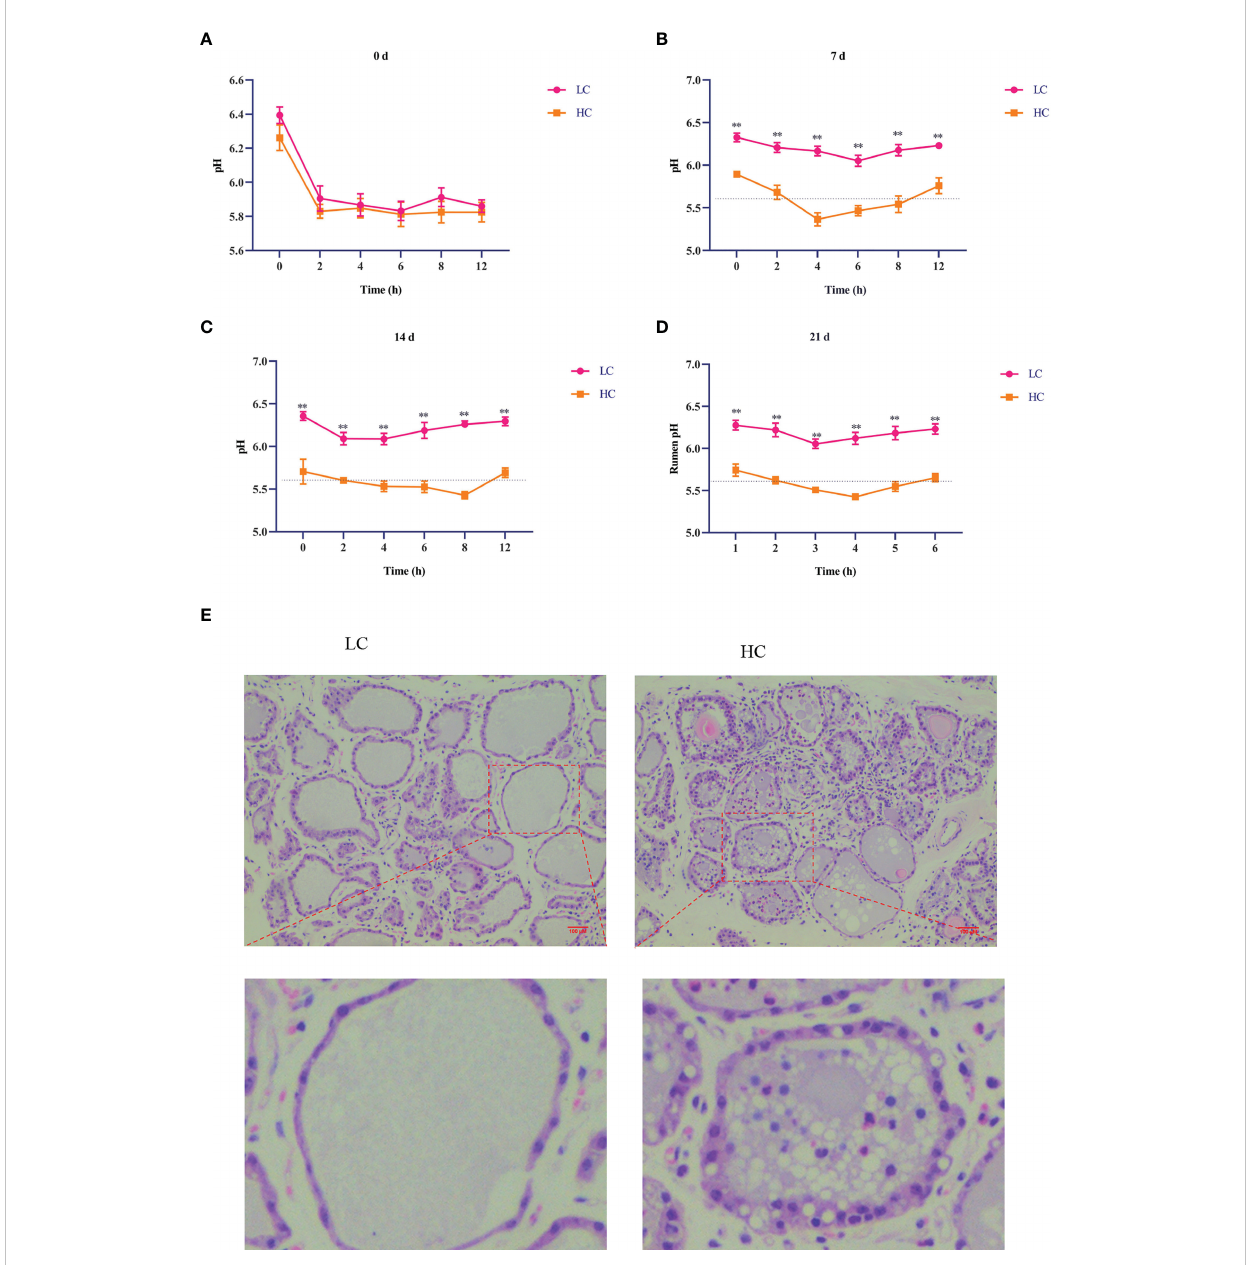
FIGURE 1 Effects of high-concentrate (HC) diet on rumen pH and hematoxylin and eosin (H&E) staining of mammary gland tissue of dairy cows. Rumen pH of dairy cows at different times (A – D) . All results are expressed as the mean ± SEM. ** p < 0.01. H&E staining was performed on mammary tissue sections (100× magni fi cation) of dairy cows fed low-concentrate (LC) and HC diets (E) . Red bar, 100 m